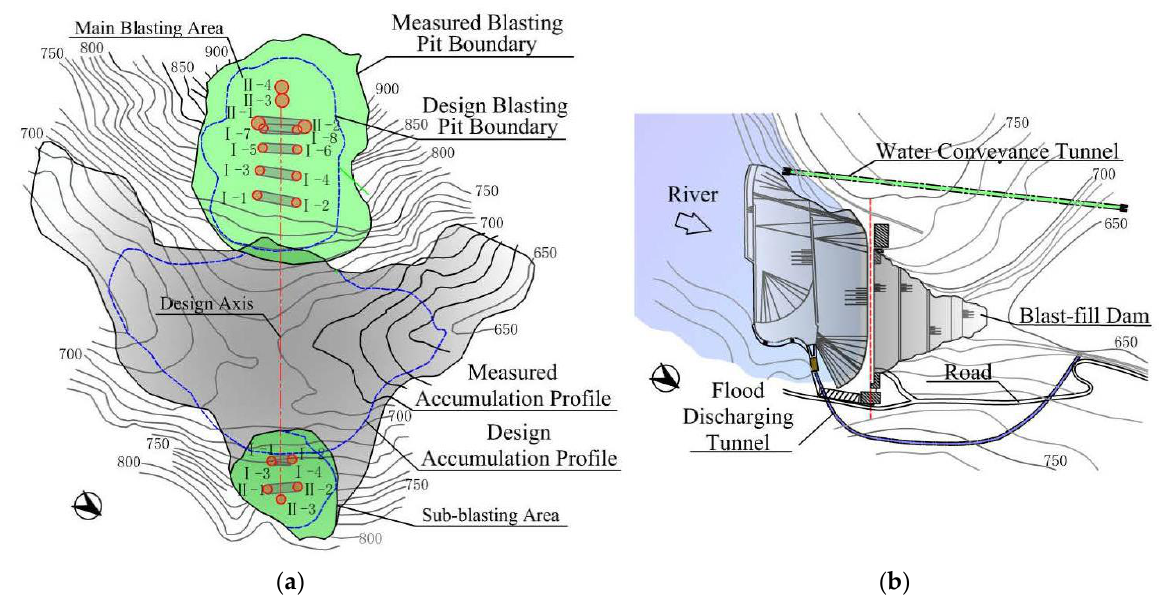
Figure 1. Comparison before and after construction of the blast-fill dam: ( a ) layout of explosion chambers and topographic map before blasting; ( b ) layout of the completed